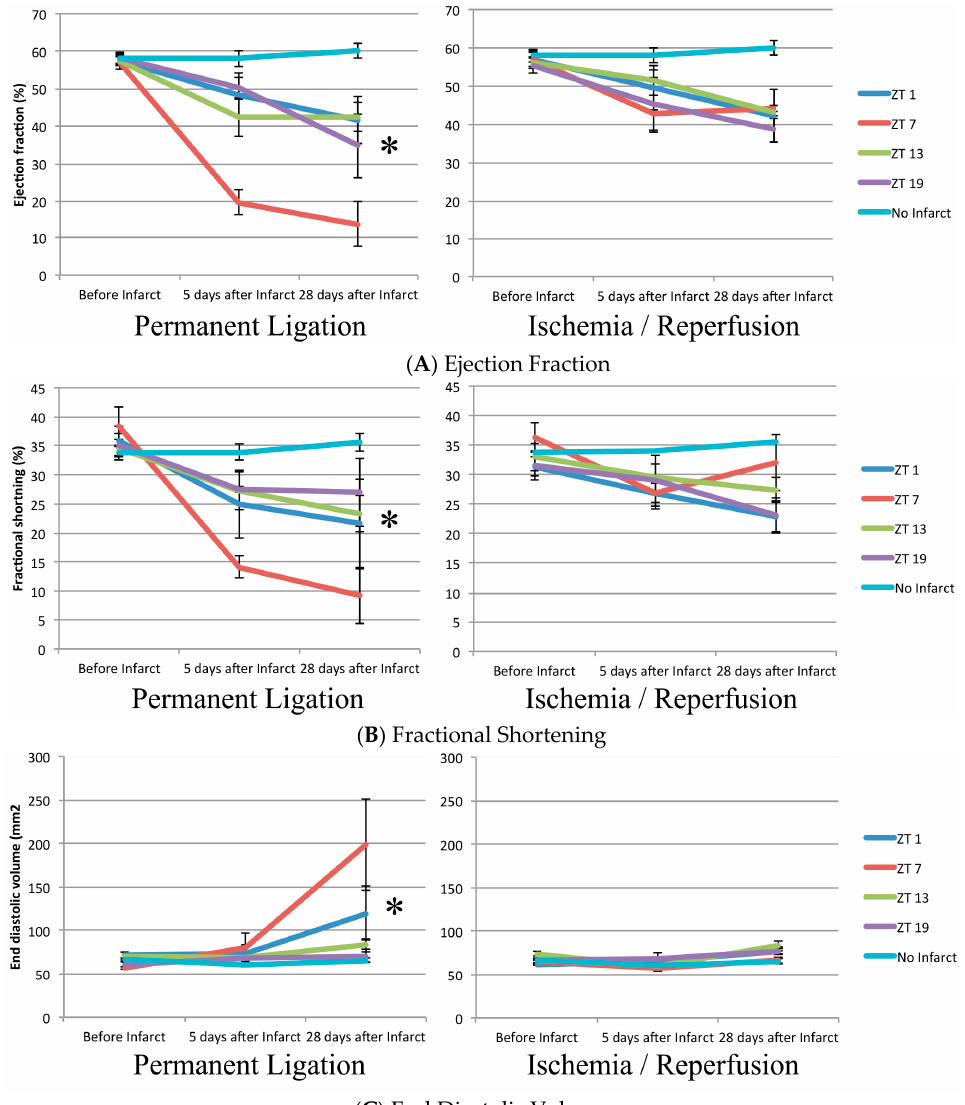
Figure 3. Echocardiographic parameters 5 days before, 5 days after, and 28 days after myocardial infarct. n = 20, 18, and 14 for PL, IR, and sham respectively, n = 3–5 per timepoint. * Indicates p < 0.05 for the presence of 24-h rhythm. ZT, Zeitgeber Time (ZT0 = lights on).